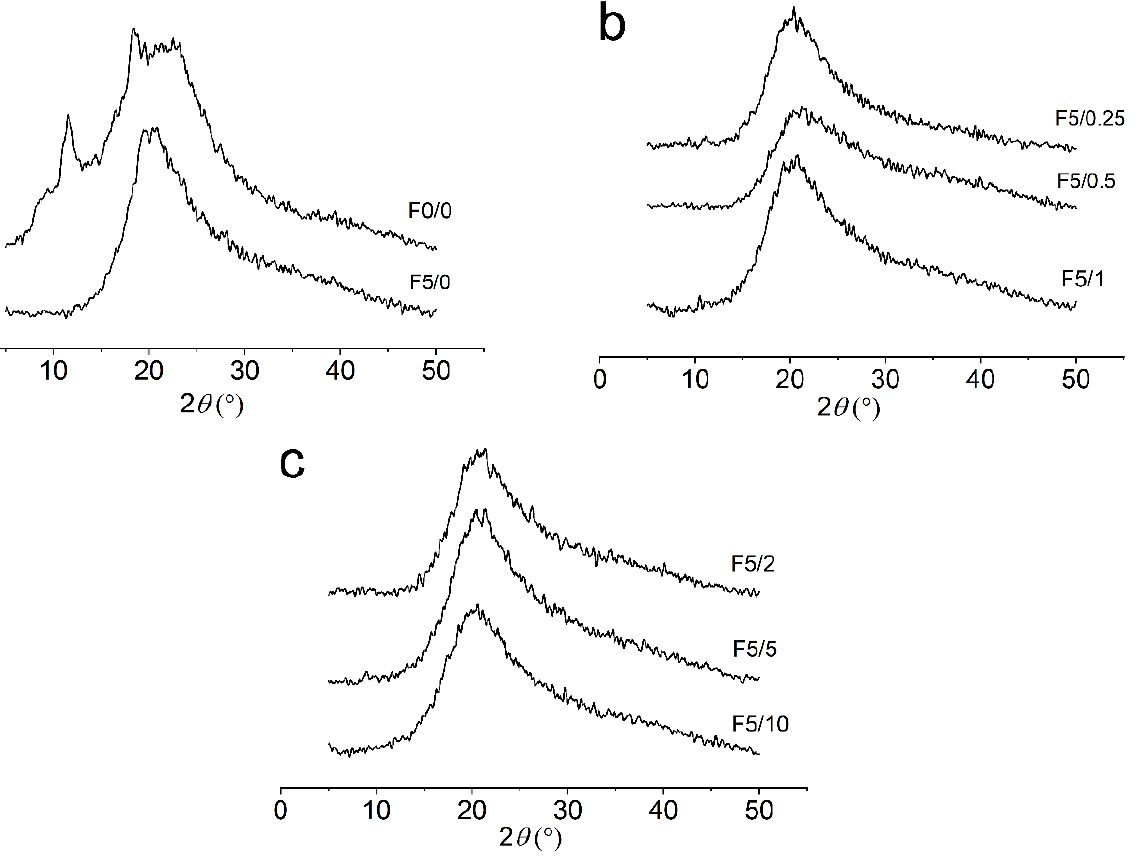
Figure 5. XRD patterns of the CS composite films for ( a ) pure CS (F0/0) and CS-DES (F5/0), ( b ) F5/0.25, F5/0.5 and F5/1, and ( c ) F5/2, F5/5 and F5/10.